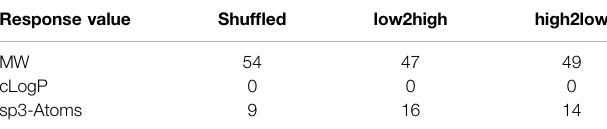
TABLE 5 | Summary of the best results for the three response datasets. Rank count for the top three ranks. The ranks were calculated from all descriptors, methods, and fractions of training